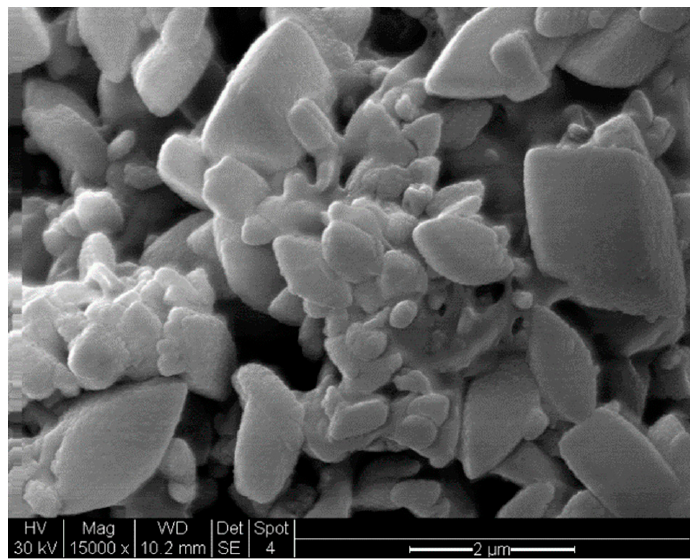
Figure 10. SEM image of BaSO 4 formed in the presence of sulfate and NOM from Ohio River water.